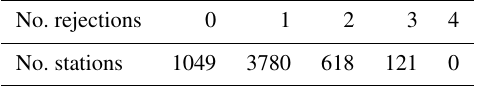
Table 2. Number of stations for which 0, 1, ..., 4 of the consid-